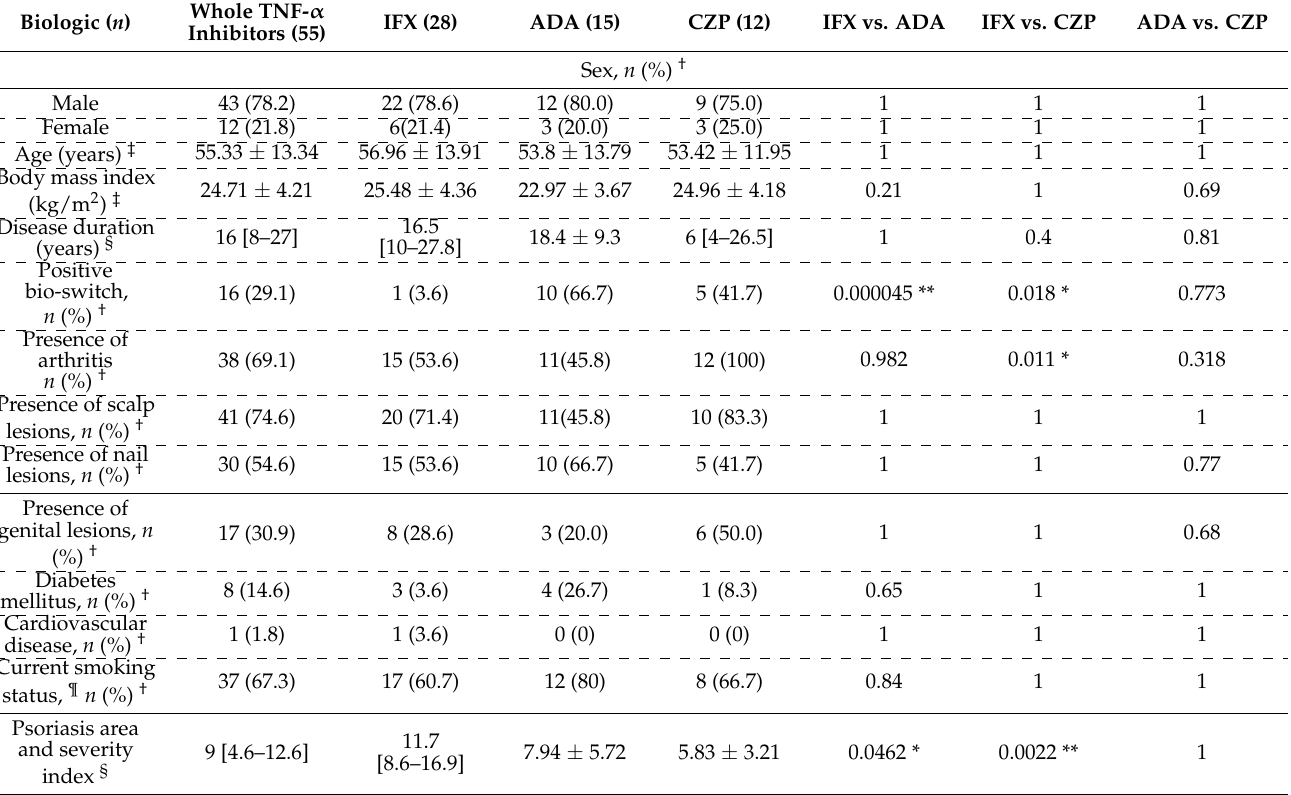
Table 1. Baseline characteristics of patients with psoriasis treated with tumor necrosis factor (TNF)- α